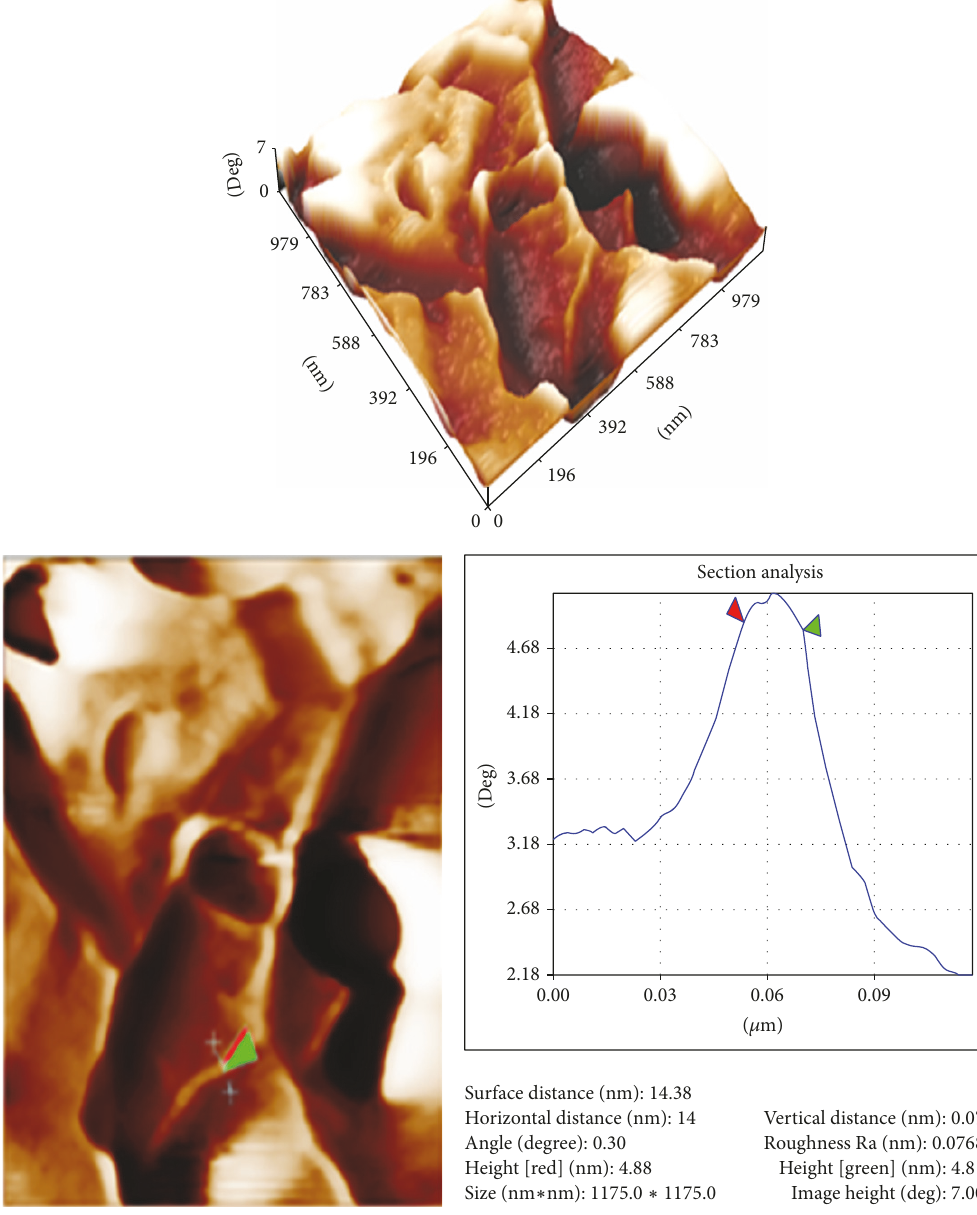
Figure 9: AFM images show the 3D and section line analysis of electroreduced GO produced by modified Hammers method from graphite